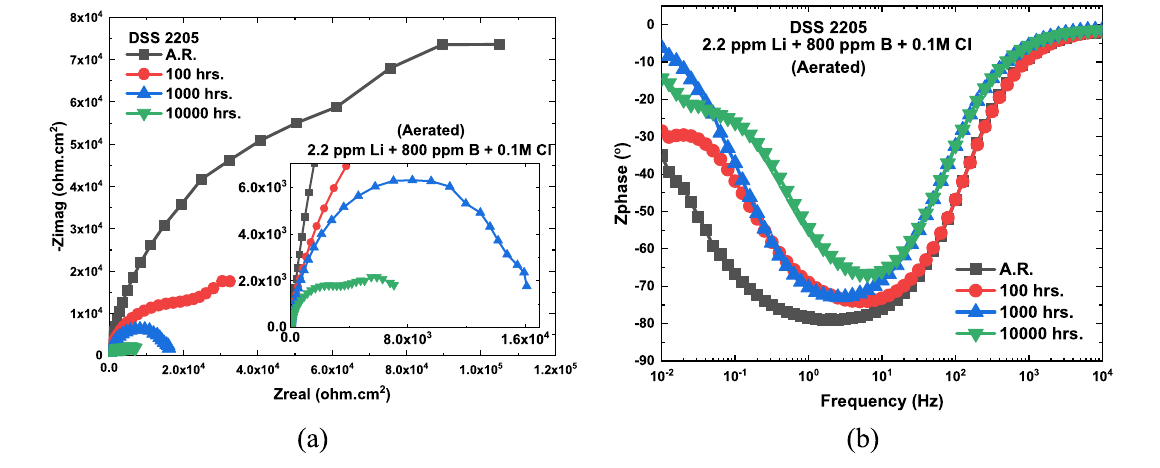
tion showing decreasing impedance and phase angle values with increasing thermal aging